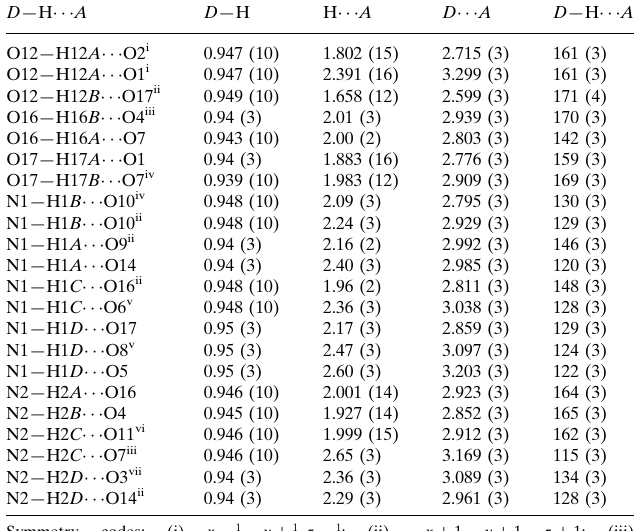
Hydrogen-bond geometry (A˚ , (cid:4)